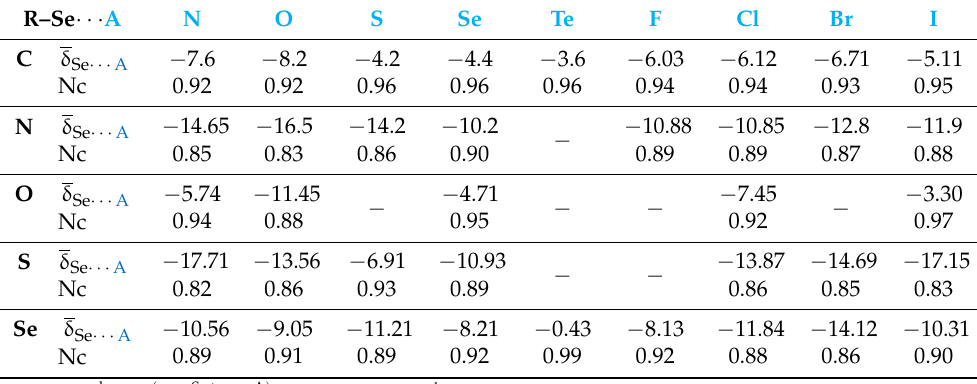
Table 2. Mean of δ Se ··· Aa values ( δ Se ··· A ) and Nc b values calculated for the fragments R–Se · · · A. R = C, N, O, S, and Se; A = N, O, S, Se, Te, F, Cl, Br, and